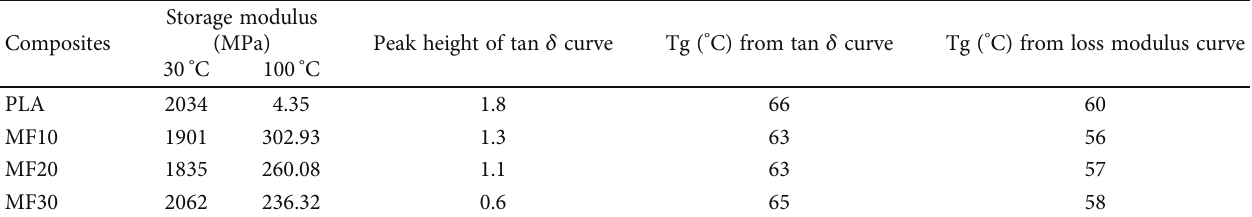
Figure 13: (a) Storage modulus curve of PLA/MF composites with di ff erent fi ber loading (10 wt. %-30 wt. %). (b) Loss modulus curve of PLA/MF composites with di ff erent fi ber loading (10 wt. %-30 wt. %). (c) Tan Delta curve of PLA/MF composites with di ff erent fi ber loading (10 wt. %-30 wt. %). Table 8: Storage modulus, loss modulus, and tan δ of PLA/MF